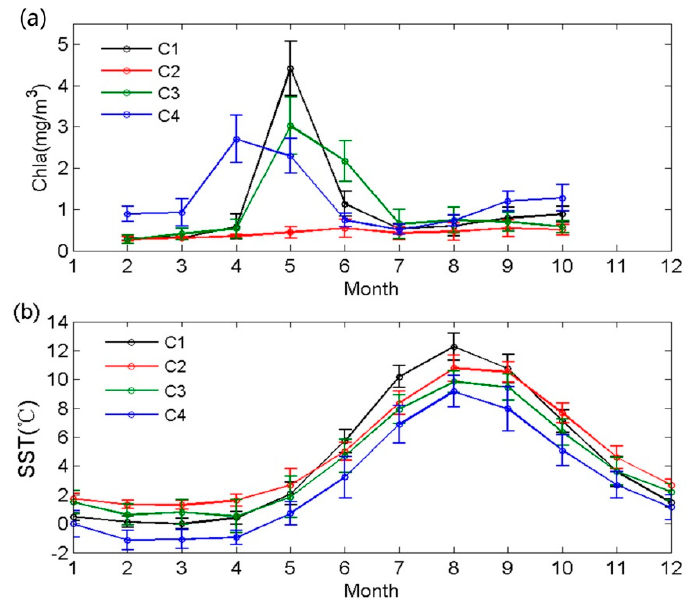
Figure 10. The climatologic monthly satellite chla and SST variation in 2002–2014 in the typical areas in Kamchatka basin (C1: 56.5–59.5°N, 166–169°E), the eastern basin (C2: 56–58°N, 173–176°E), slope (C3: 59–61°N, 179°E–181°W), and shelf (C4: 58–61°N, 188–190°W); and the locations are shown in box C1, C2, C3, and C4 in Figure 3d. Error bars are the standard deviation of the data in an individual month from 2002 to 2014.